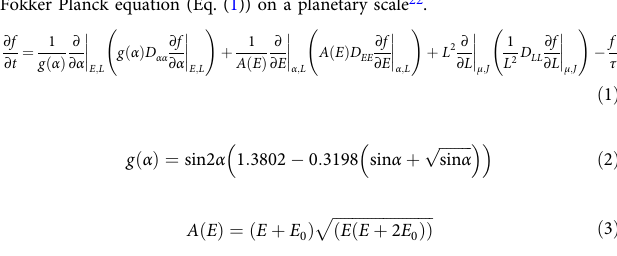
where f is the phase space density, t is time, α is the equatorial pitch angle, D αα , D EE , and D LL are the drift-averaged and bounce-averaged pitch angle, energy, and radial diffusion coef fi cients, respectively, E is the energy, L is the L-shell, µ and J are the fi rst and second adiabatic invariants, E 0 is the electron rest energy, and τ is the loss timescale. The diffusion coef fi cients are calculated using the PADIE code 15 which solves the resonance condition for cold plasma dispersion in a magnetic fi eld. We use a centered dipole magnetic fi eld with an equatorial surface magnetic fi eld strength,